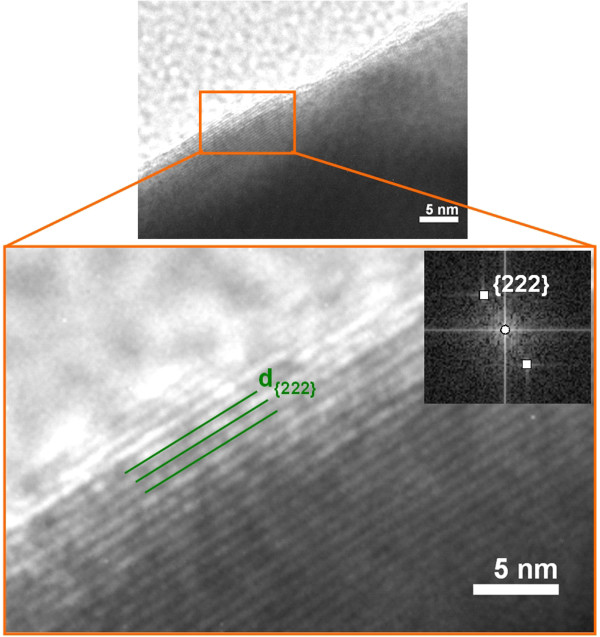
HRTEM image and FFT pattern of (Er,Yb):Lu2O3 nanocrystals immersed in PMMA microcolumns.